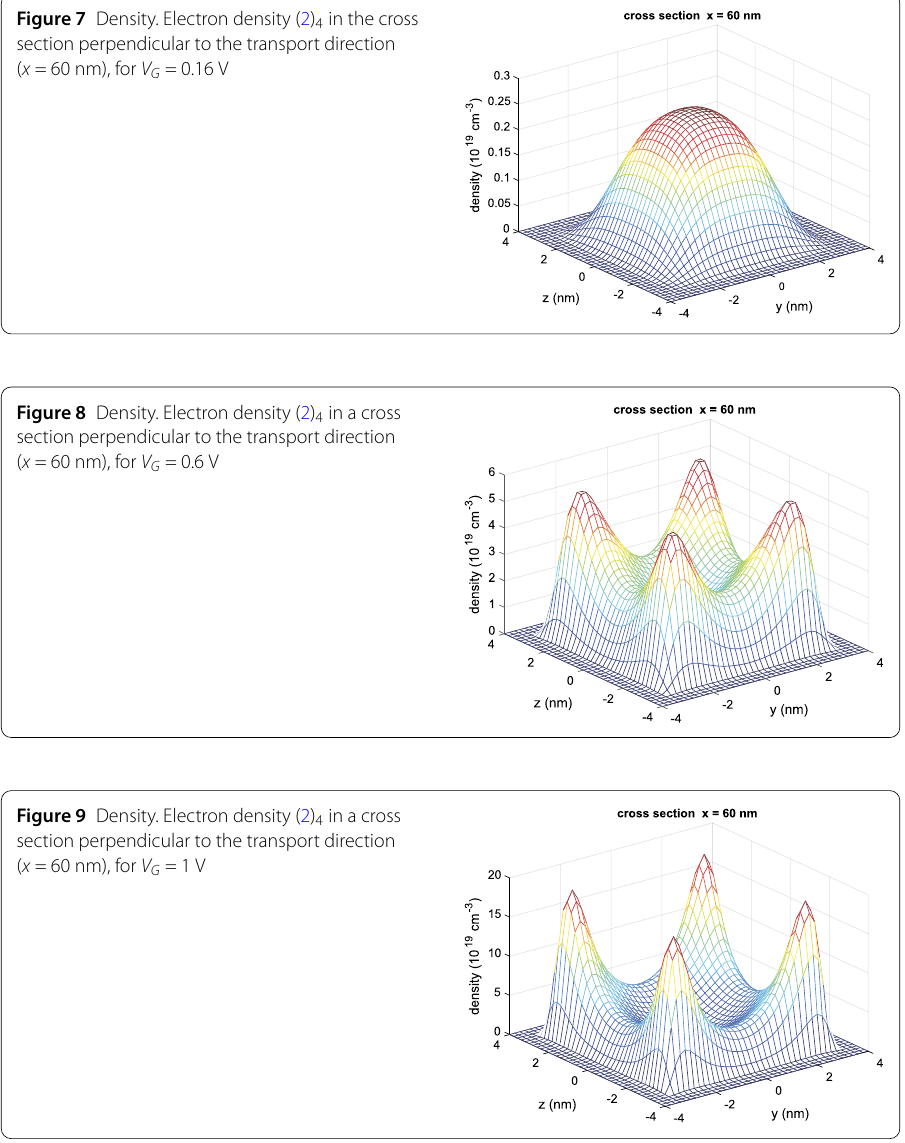
Figure 7 Density. Electron density (2) 4 in the cross section perpendicular to the transport direction ( x = 60 nm), for V G = 0.16 V